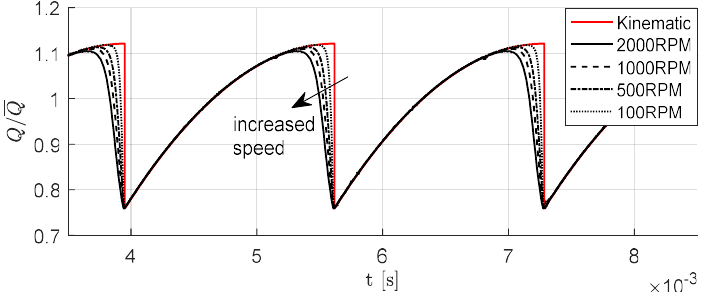
Figure 17: Reference pump simulated with minimum-delivery groove positioning simulated fluid- dynamic flow ripple at 0 bar pressure differential and different shaft speeds, as well as the kinematic flow ripple plotted.